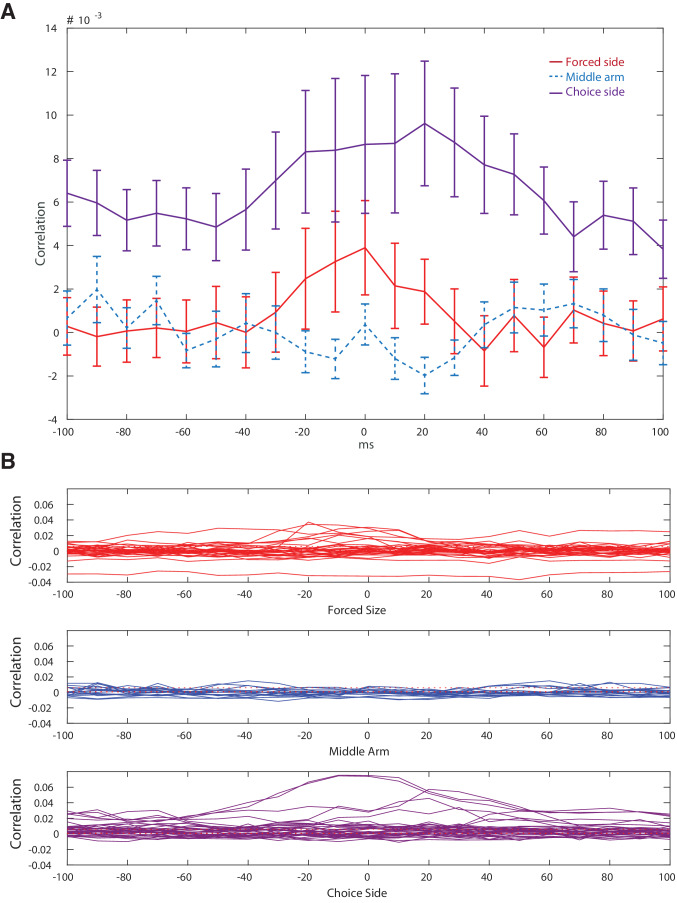
Differences in cross correlations are not due to differences HPC-LS place field pair proximity in the different maze arms.We sought to ensure that the higher cross correlation values were not the result of more place fields in the choice arm resulting in a lower average difference between field centers of HPC-LS matched pairs. We first decided to determine if there was a difference in the average distance between LS and HPC place field pairs for the forced side, central stem, and choice side. We found that there was no significant difference between the average distance between LS and HPC pairs in the forced arm versus choice arm (two-tailed two sample t-test, t(67) = 1.8, p>0.05), so the proximity of HPC-LS pairs did not account for the difference in cross correlation values for forced vs. choice sides. There was a small (3cm) but significant (two-tailed two sample t-test, t(51) = 2.2, p=0.03) difference in distances when comparing the choice side to the middle stem. (Running a one way anova with all three values, F(3,83) = 3.24, p = 0.04). To further ensure that distance between pair centers was not causing the increase cross correlation in the choice arm, we subsampled the data. We found that eliminating the very closest pairs (pairs that had centers within 3cm of each other) was more than sufficient to result in an insignificant difference between forced, choice, and middle pair distances (one way anova F(3,84) = 1.92, p>0.05, with both t-tests also p>0.05). When subsampled as described, the average cross correlation for pairs on the choice side was still significantly higher than the average in either the forced side or middle stem (double sided t tests, t(51) = 1.96 p<0.05 for comparing forced to choice and t(51) = 2.2 p<0.05 for comparing central to choice). (A) The average cross correlations of subsampled data. (B) All cross correlations of subsampled data.